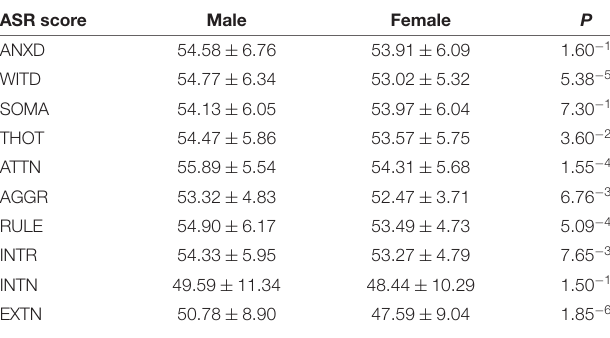
TABLE 1 | Subjects’ statistics for 10 ASR